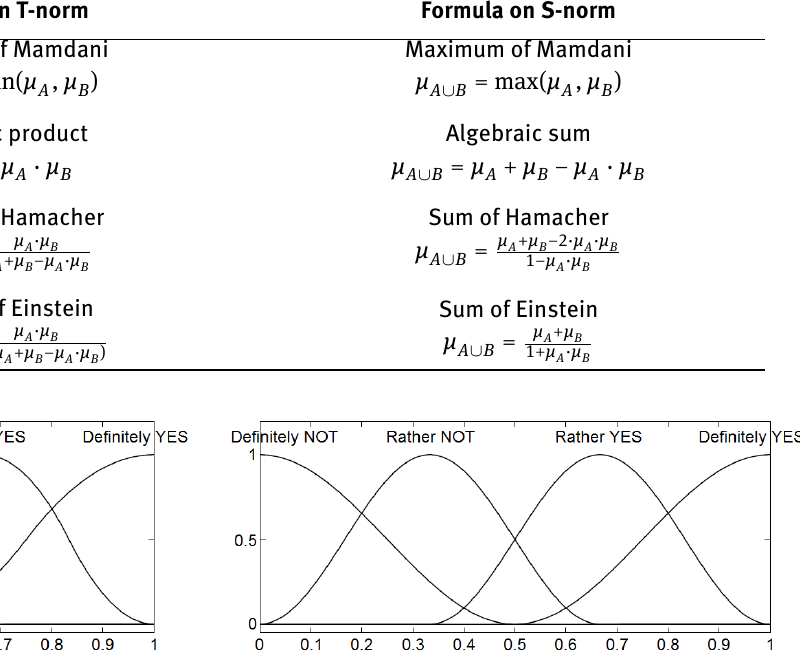
Table 2: Selected rules for the intersection and sum operation of fuzzy sets Set No.